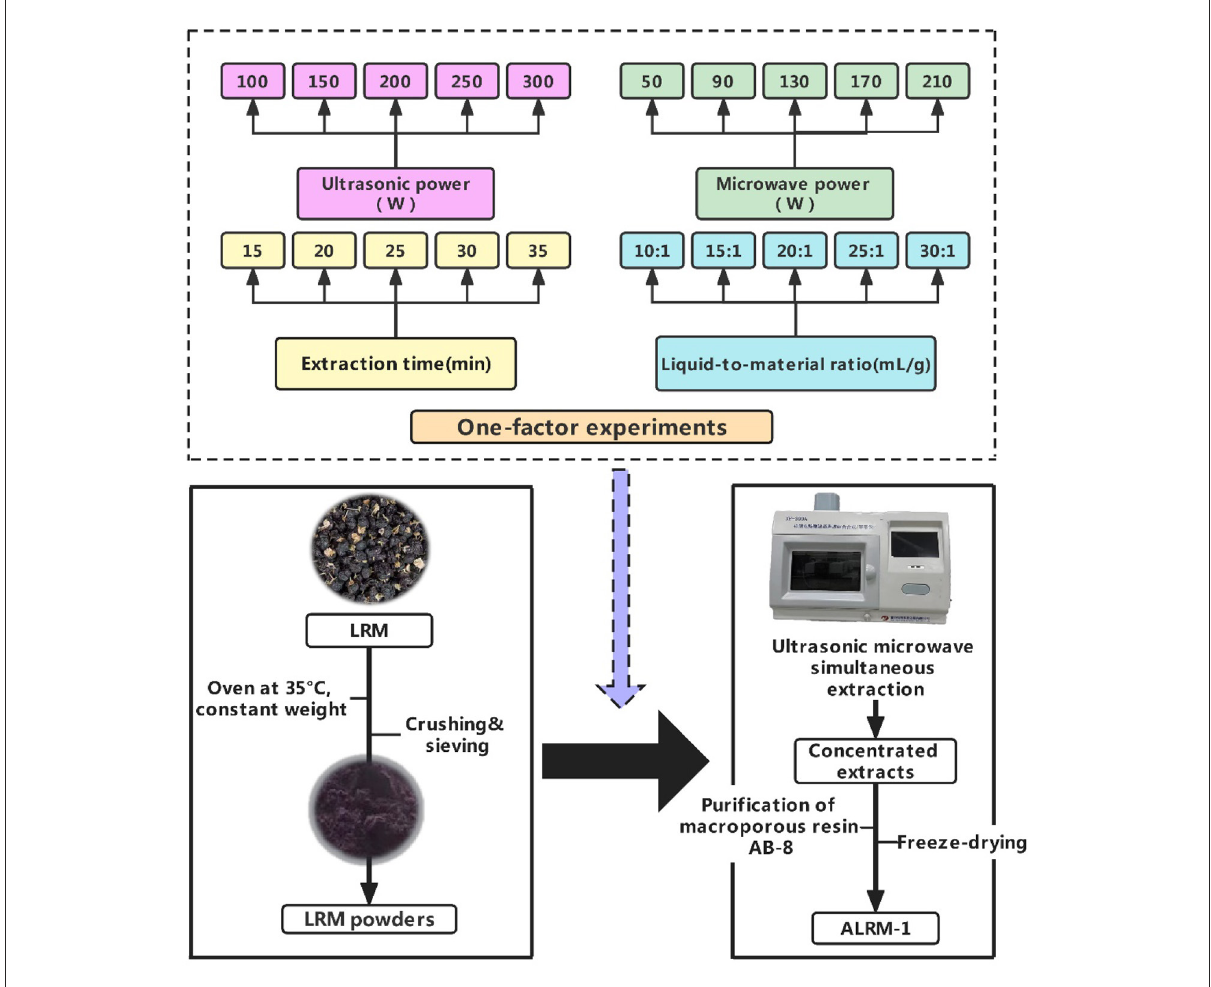
FIGURE1 The procedure for the extraction and purification of ALRM-1.